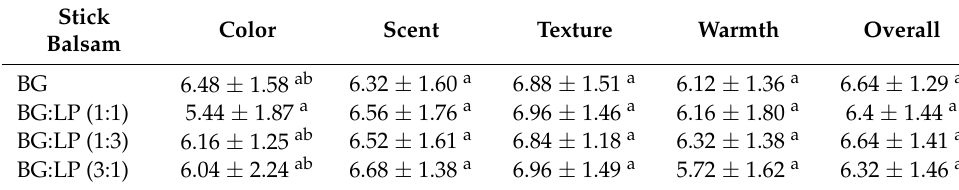
stick balsam for color parameters and LP stick balsam for aroma and texture parameters. On warmth parameters, panelists tended to prefer the BG:LP (1:3) stick balsam. The most preferred formulations were the BG stick balsam and the combination of BG and LP (1:3) stick balsam based on the overall value (Figure 4). Table 3. Organoleptic results of spice stick balsam. Stick Table 3. Cont. Color Scent Texture Warmth Overall Balsam Stick Color Scent Texture Balsam